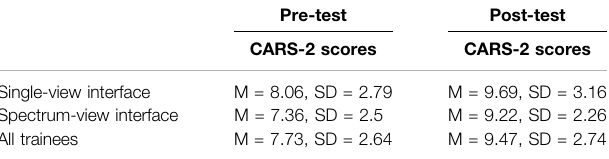
TABLE 3 | CARS-2 scores (max-score (cid:2)